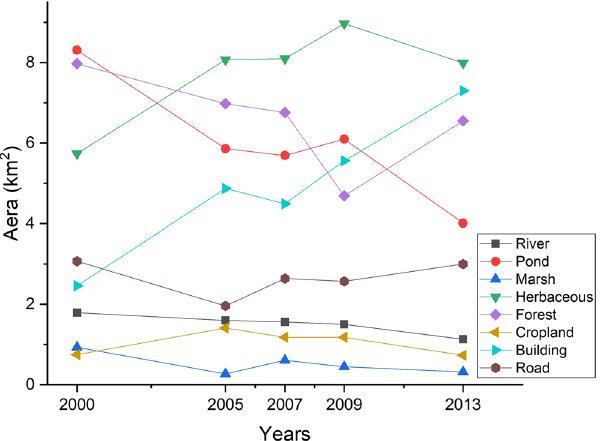
Figure 3. The change statistics for five years (2000, 2005, 2007, 2009 and 2013). This figure was created using Origin ® 2018 by OriginLab Corporation. Origin is an industry-leading scientific graphing and data analysis software and is used here under license. For more information about Origin software, please visit www.